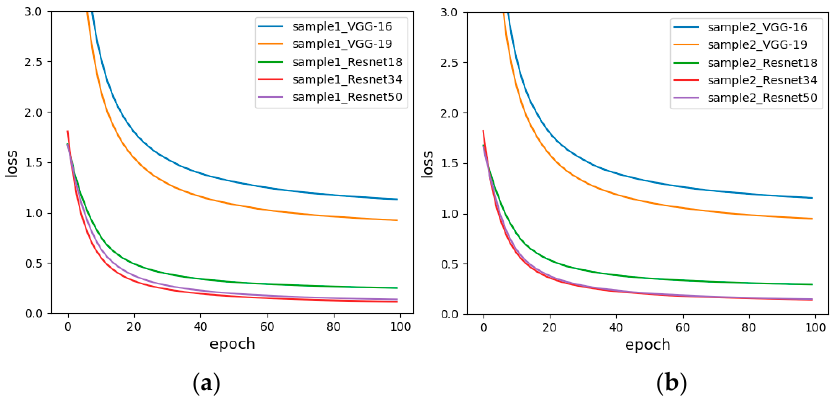
Figure 11. The loss functions before and after fixing range response values, ( a ) Unfixed range of response values (Sample-set 1); ( b ) Fixed range of response values (Sample-set 2).